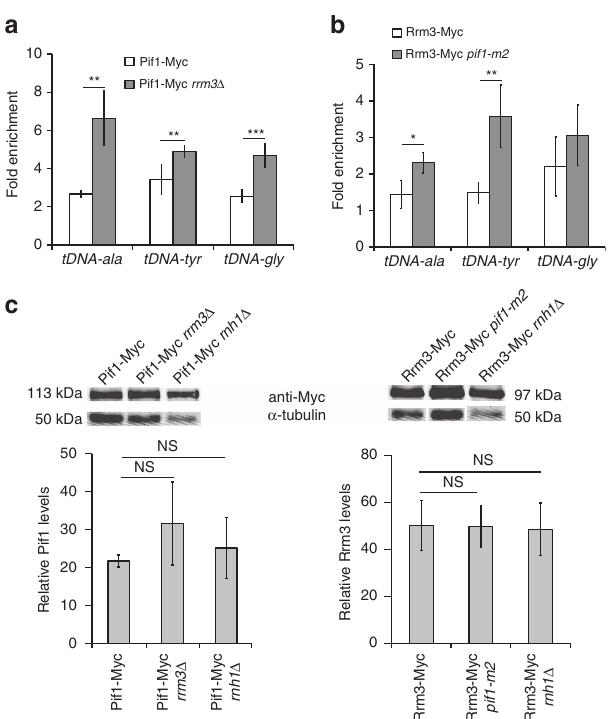
Figure 1 | Pif1 and Rrm3 bind tDNAs. Enrichment of Pif1 (ChIP/input) or Rrm3 (ChIP/input) at tDNAs was normalized to helicase enrichment at YBL028C , a site that has low binding to both helicases. ( a ) Fold enrichment ([ChIP/input] tDNA /[ChIP/input] YBL028C ) of Pif1-Myc in asynchronous wild- type (WT) and in rrm3 D cells at tDNA ala HO, tDNA tyr HO and tDNA gly HO. ( b ) Fold enrichment of Rrm3-Myc in asynchronous WTand pif1-m2 cells at tDNA ala HO, tDNA tyr HO and tDNA gly HO. Full blots are shown in Supplementary Fig. 7. ( c ) Western blot (top) and its quantification (bottom) showing Pif1 or Rrm3 expression levels in WT, rrm3 D , pif1-m2 and rnh1 D cells. All quantification was normalized to the loading control, a -tubulin. The difference in Pif1 abundance between WTand rrm3 D or rnh1